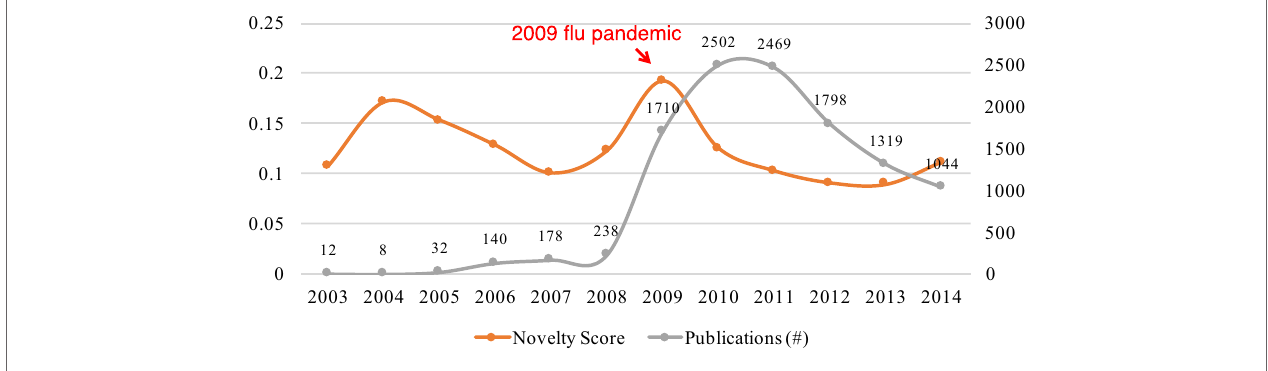
FIGURE 3 | Co-evolution of the novelty and growth of research on H1N1 virus.